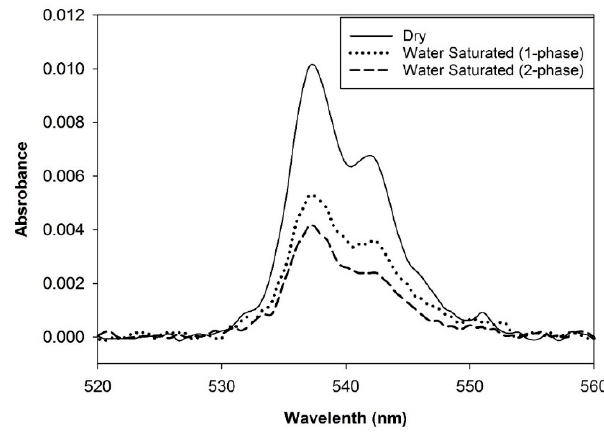
Figure 10. UV–VIS spectra from 520 nm to 560 nm of Ho-TBDGA complex in 0.5 mole percent 1-octanol modified CO 2 (l) at 23 ◦ C and 24.1 MPa. By integrating the area under the peak the Ho concentration was determined. The integrated molar extinction coefficient or the peak from 529 nm to 554.5 is 26.6 A · nm · M − 1 · cm − 1 . The dry system (a solid black line) has a Ho concentration in the CO 2 (l) of 2.57 mM. The water saturated CO 2 (l) 1-phase wet system (dotted black line) had 4 µ L of water added, and the Ho concentration in the CO 2 (l) was determined to be 1.45 mM. The 2-phase wet system (dashed black line) had 100 µ L of water added, and the Ho concentration in the CO 2 (l) of 1.04 mM.